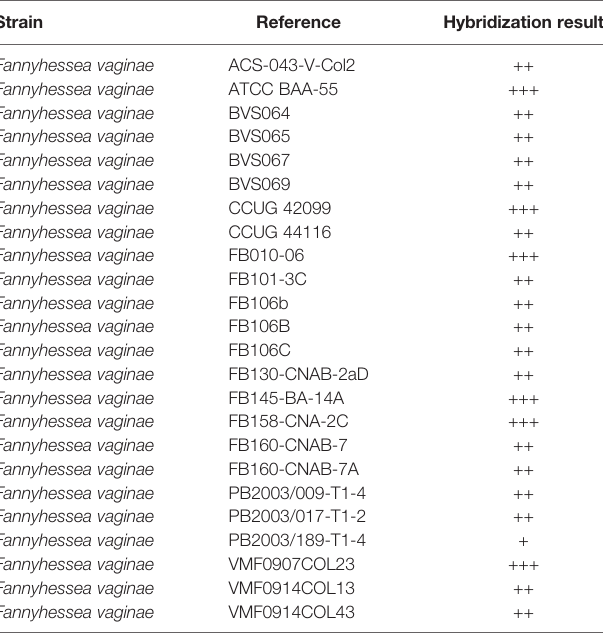
TABLE 1 | Hybridization of F. vaginae probe with different strains of F. vaginae for determination of analytical sensitivity. Strain